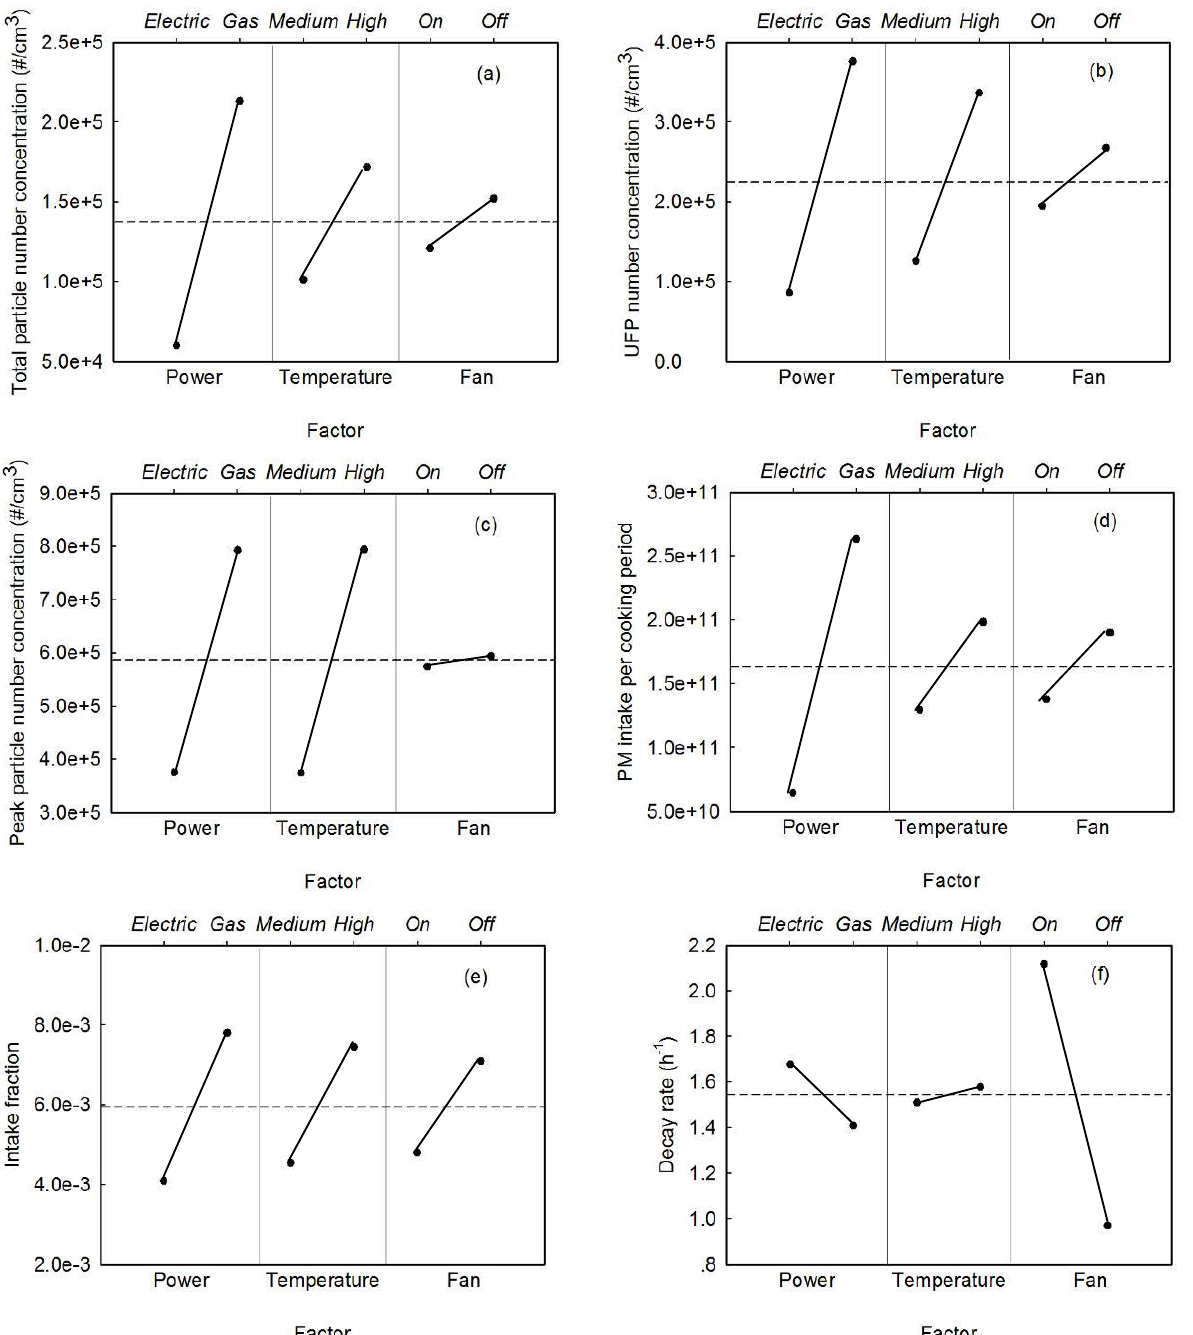
Figure 4. Results of factor analysis showing the effect of stove type, exhaust fan setting and temperature on (a) average total particle number concentration, (b) average UFP number concentration, (c) peak particle number concentration, (d) PM intake per cooking period, (e) intake fraction and (f) decay